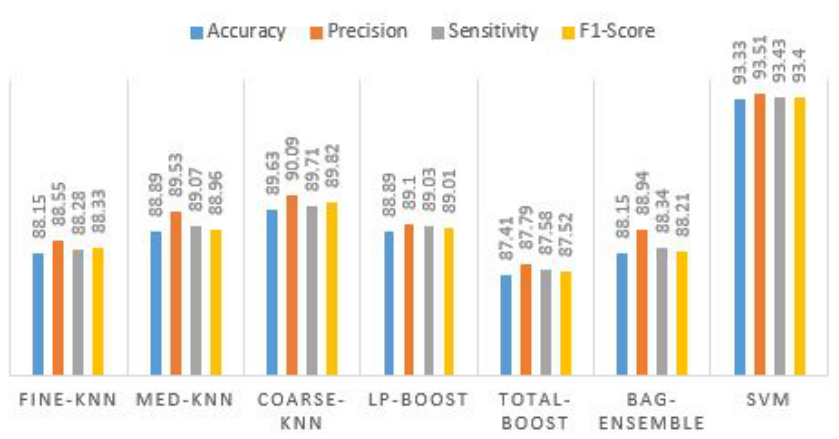
Figure 8. Prediction plot obtained using different ML classifiers on 70-30 split.